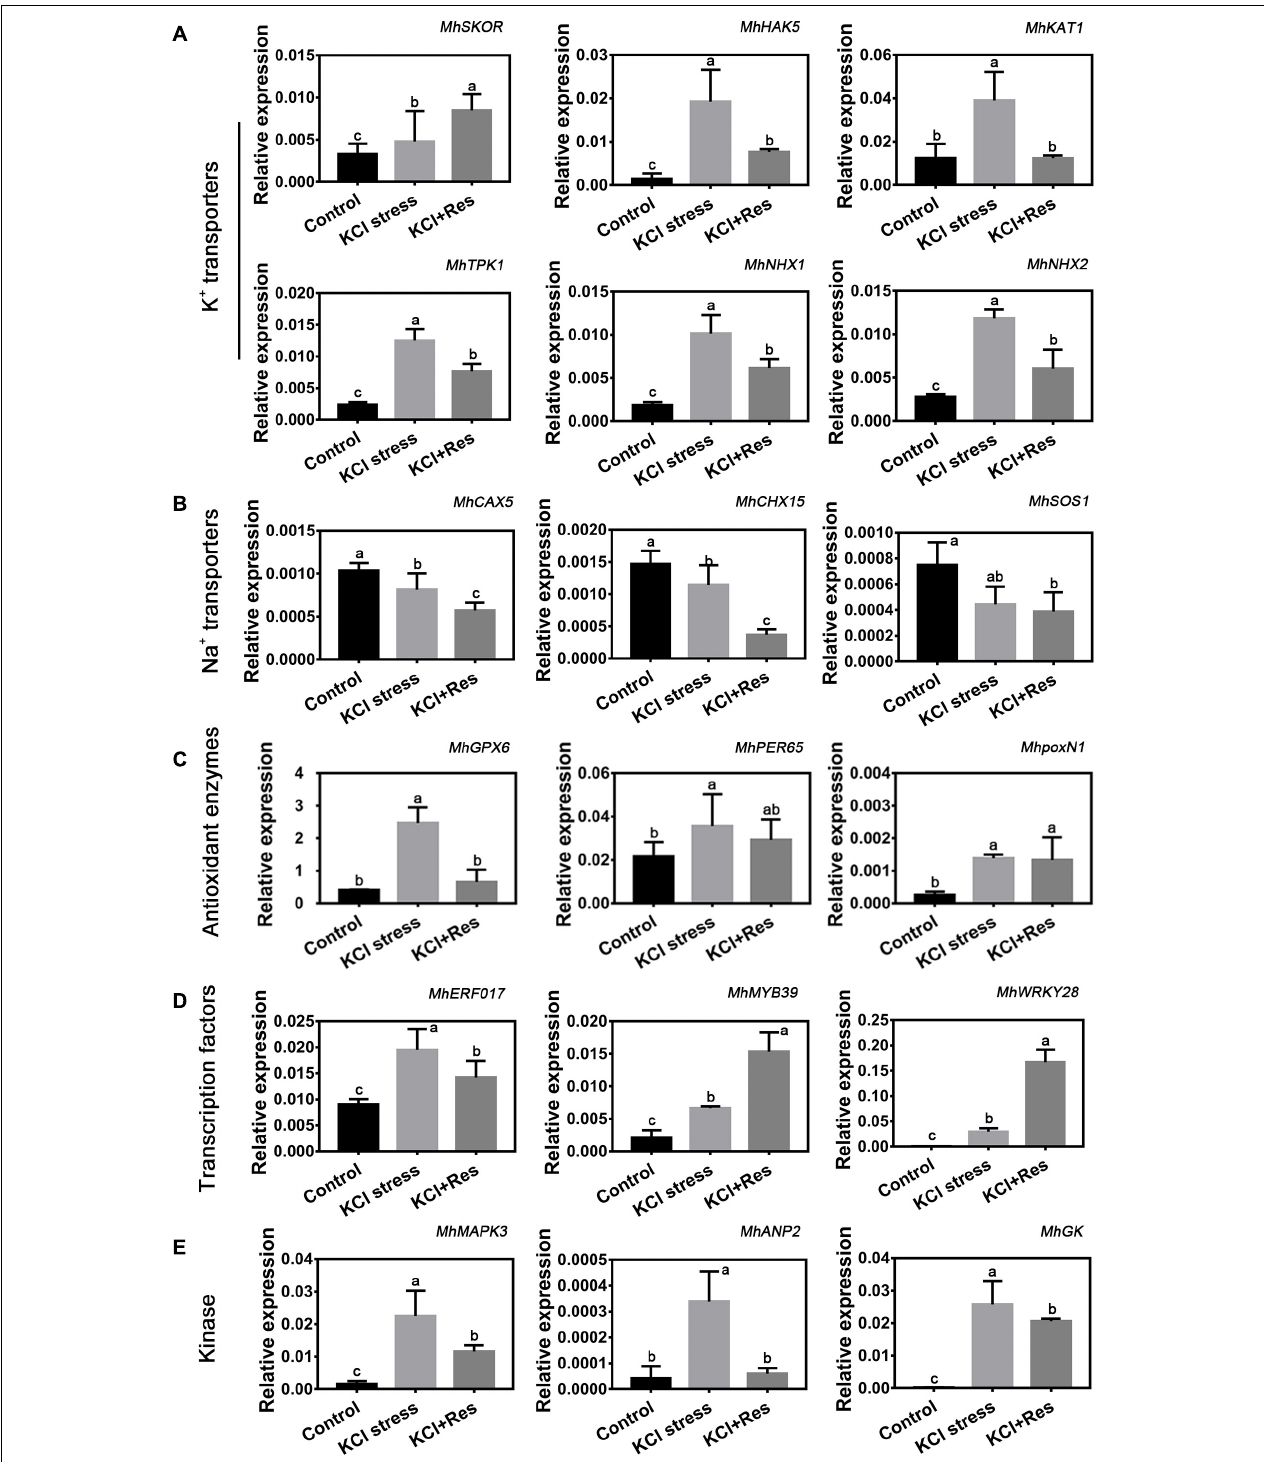
FIGURE 6 | Eighteen candidate genes are divided into K + transporters ( MhSKOR , MhHAK5 , MhAKT1 , MhTPK1 , MhNHX1 , and MhNHX2 ) (A) , Na + transporters ( MhCAX5 , MhCHX15 , and MhSOS1 ) (B) , antioxidant enzymes ( MhGPX6 , MhPER65 , and MhpoxN1 ) (C) , transcription factors ( MhERF017 , MhMYB39 , and MhWRKY28 ) (D) , and kinase ( MhMAPK3 , MhANP2 , and MhGK ) (E) . The expression of the 18 candidate genes under KCl stress and exogenous Res treatment for 15 days. The data represent the mean ± SD of biological replicates. Different lowercase letters indicate significant differences according to Fisher’s least significant difference ( P <